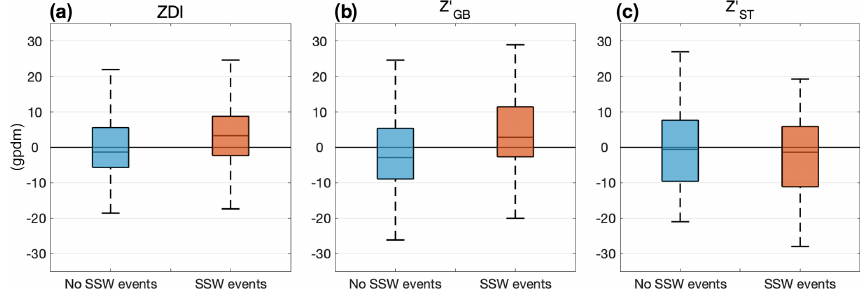
Figure 5. Distribution of weekly means of the (a) ZDI, (b) Z (cid:48) weeks after SSW events (blue) and after SSW events (orange). On each box, the central line shows the median, and the bottom and top edges indicate the 25th and 75th percentiles,